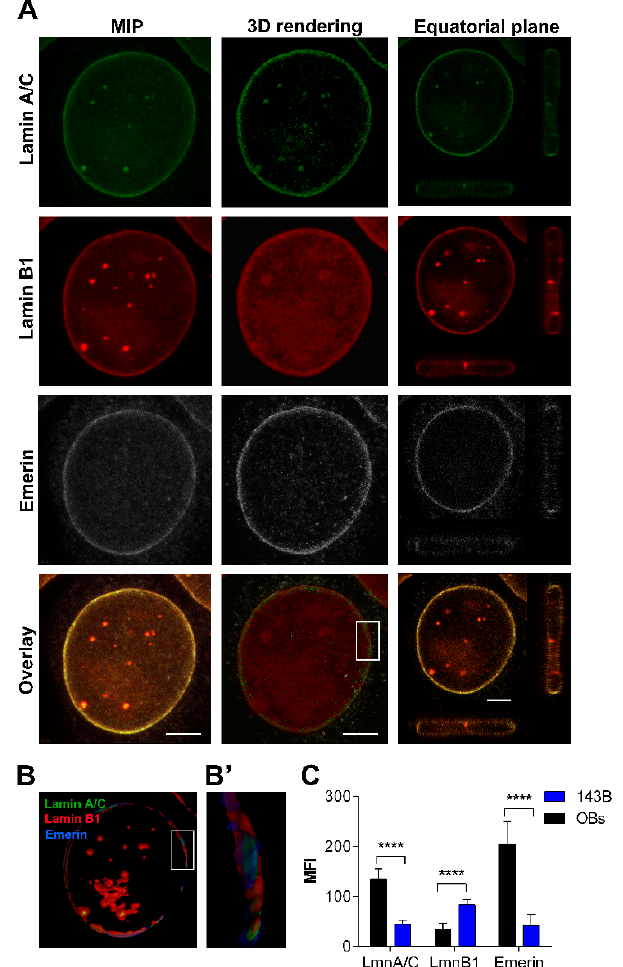
Figure 6. Behaviour of lamins and emerin, and nuclear morphology in 143B cell line. ( A ) Maximum intensity projection (MIP) of series of z-stacks images covering the entire nucleus (left column), 3D rendering in blend volume mode (central column, LAS X 3D software, Leica Microsystems, Wetzlar, Germany), and XZ- and YZ-axes projections performed in the central focal plane of the nucleus (right column) are shown. Bars: 5 µ m. Lamin A / C (red) decreased and emerin (white) was mildly polymerized and interdispersed around the nuclear rim and in the cytoplasm. ( B ) 3D rendering in the focal central plans of the nuclear rim in surface volume mode (Imaris software). Bar: 3 µ m. ( B’ ) High magnification of the 3D rendering of the boxed area showing the di ff erential expression of lamins (in green and red) and emerin (pseudocoloured in blue). Bar: 1 µ m. ( C ) Mean Fluorescence Intensity (MFI) of lamins and emerin immunoexpression in 143B cells, in comparison to normal OBs. ****: p < 0.001.